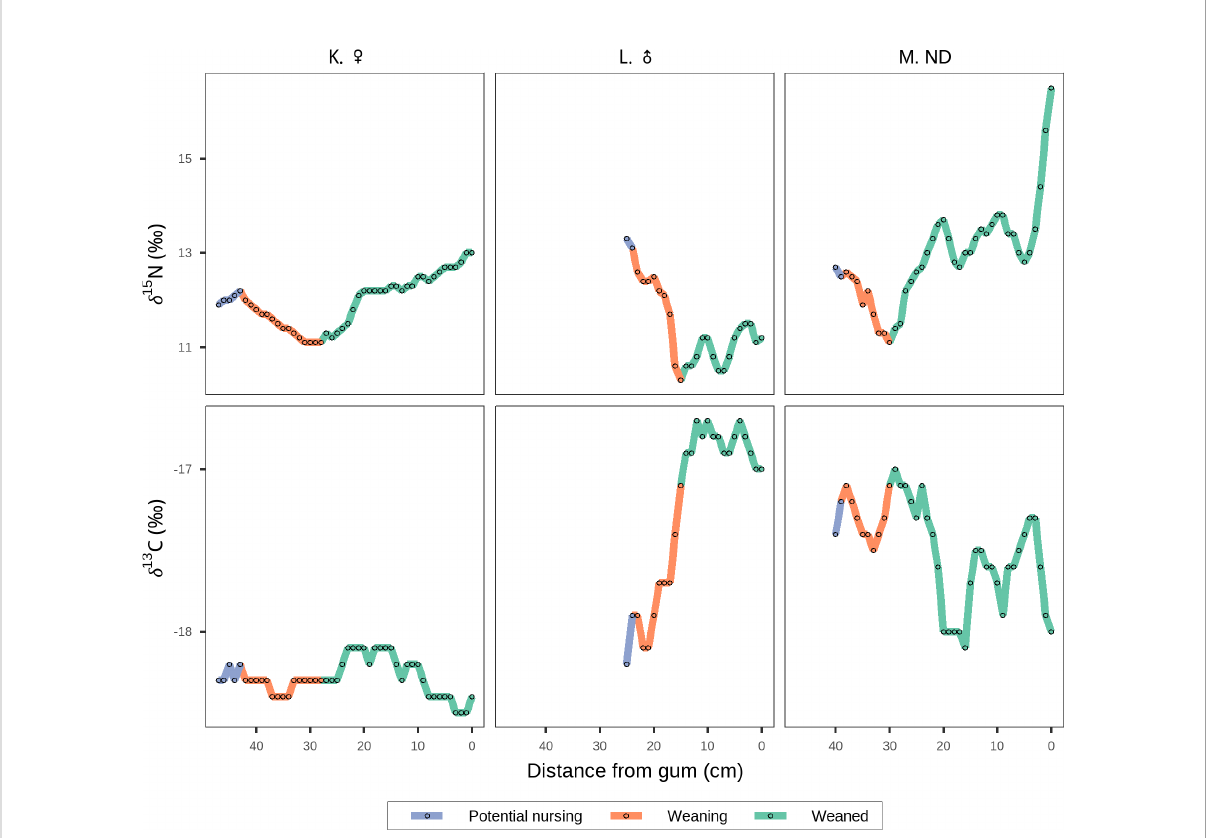
FIGURE 6 d 15 N and Suess corrected d 13 C oscillations along the baleen plates of recently weaned whales. Colors indicate likely periods of potential nursing (purple), weaning (orange), and active foraging/weaned (green). Figure shows whales K, L and